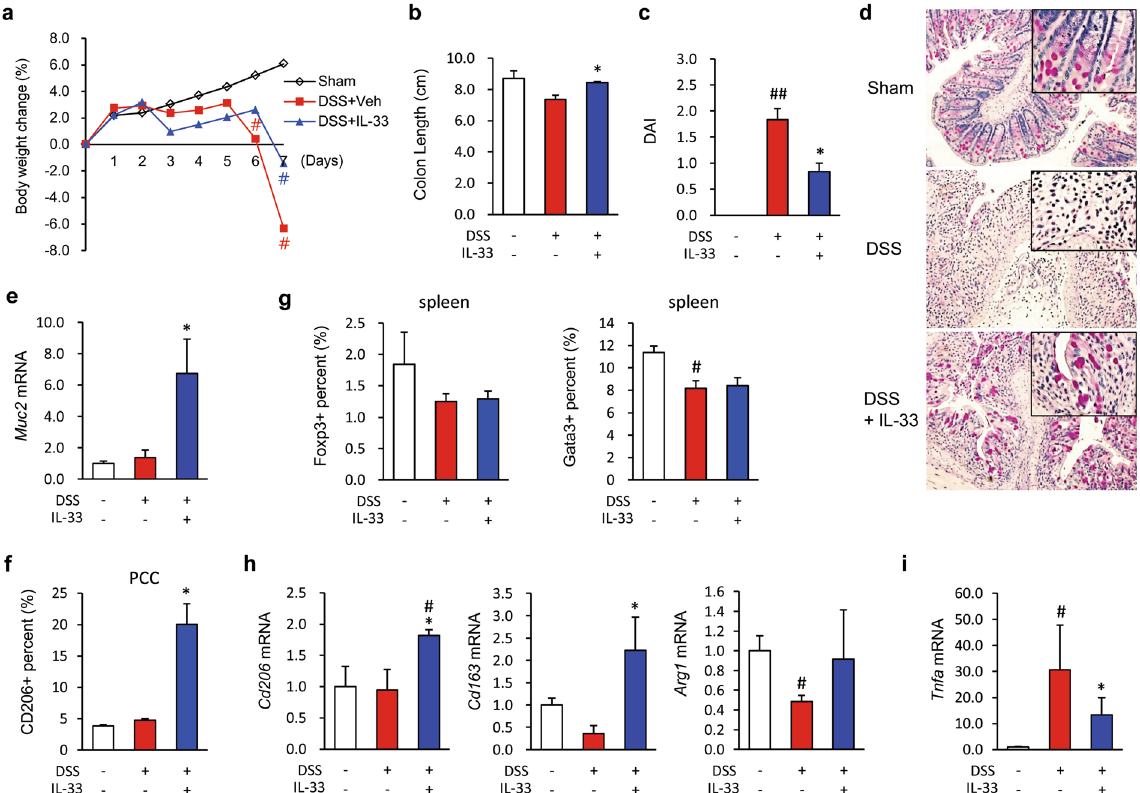
Figure 2. Effects of IL-33 on dextran sodium sulfate (DSS)-induced colitis in mice. ( a ) Body weight changes. The weight of each mouse was followed daily. ( b ) Effects of IL-33 on colon length. ( c ) Effects of IL-33 on the disease activity index (DAI). Disease activity at day 7 was scored according to the criteria outlined in the Materials and Methods. ( d ) Representative image of periodic acid-Schiff (PAS)-stained goblet cells in the colon. ( e , h , i ) mRNA expression in the mouse colon. mRNA expression of Muc2 ( e ), M2 markers ( Cd206 , Cd163 , and Arg1 ) ( h ), and Tnfa ( i ) were evaluated by quantitative RT-PCR. ( f ) Flow cytometry analysis of the M2 macrophage (CD206 + ) populations in peritoneal cavity cells (PCCs) from treated mice. ( g ) Flow cytometry analysis of the Treg (Foxp3 + ) and Th1 (Gata3 + ) populations in the spleens of treated mice. Data are presented as means ± SE (n = 5 mice/group). Recombinant IL-33 (mrIL-33) was i.p. injected daily (0.2 μ g/mouse) for 5 days after treatment with 3% (w/v) DSS. # P < 0.05 vs. Sham control, * P < 0.05 vs. DSS as assessed by